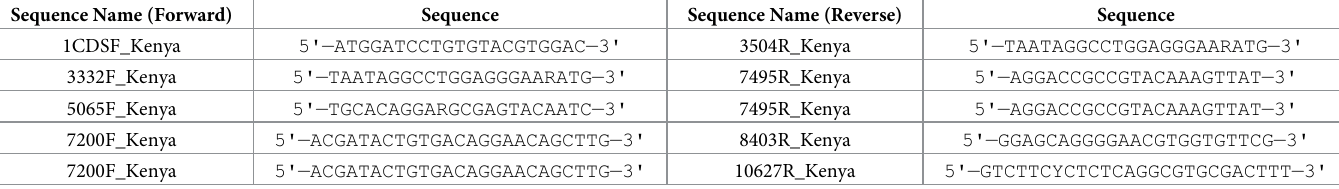
Table 1. Primers used for PCR. Five combinations of the primers were used to generate amplicons for NGS sequencing. Sequence Name